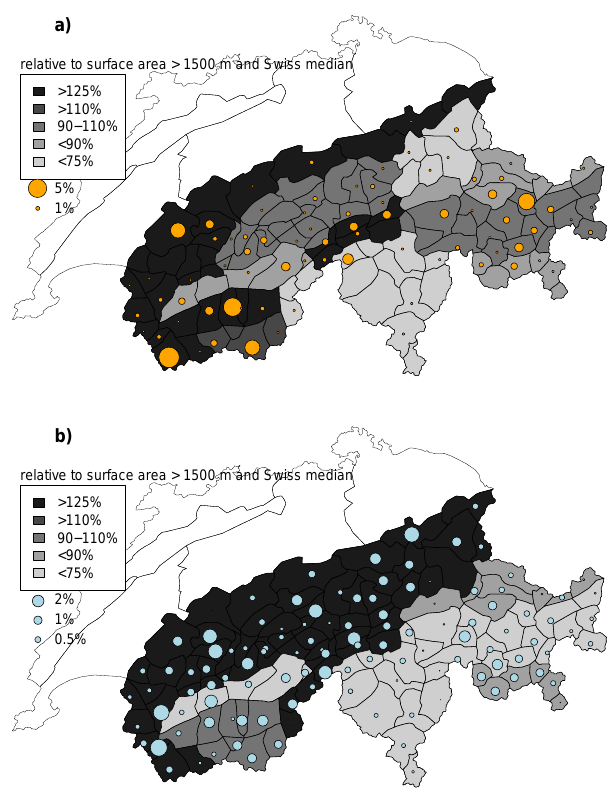
Figure 3. Geographical distribution of (a) severe avalanche acci- dents and (b) backcountry touring activity in Switzerland. The size of the circles indicates the relative proportion of all accidents or activities, respectively. The background color indicates the num- ber of accidents (or activities) in relation to the surface area above 1500ma.s.l. and is standardized by the median across all regions.